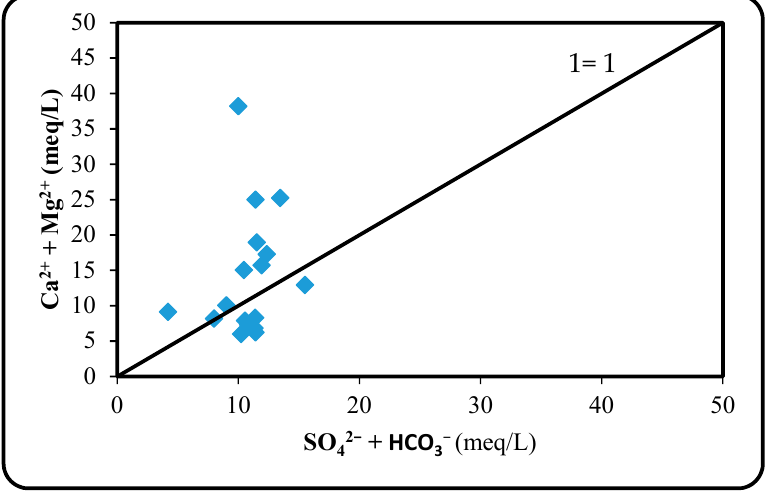
Figure 11. Ca 2+ + Mg 2+ versus SO 42 − − HCO 3 − in the groundwater of the catchment. The plot of Ca 2+ versus SO 42 − (Figure 12a) and Ca 2+ versus HCO 3 − (Figure 12b) are portraying the existence of higher concentration of Ca 2+ over SO 42 − and HCO 3 − ,